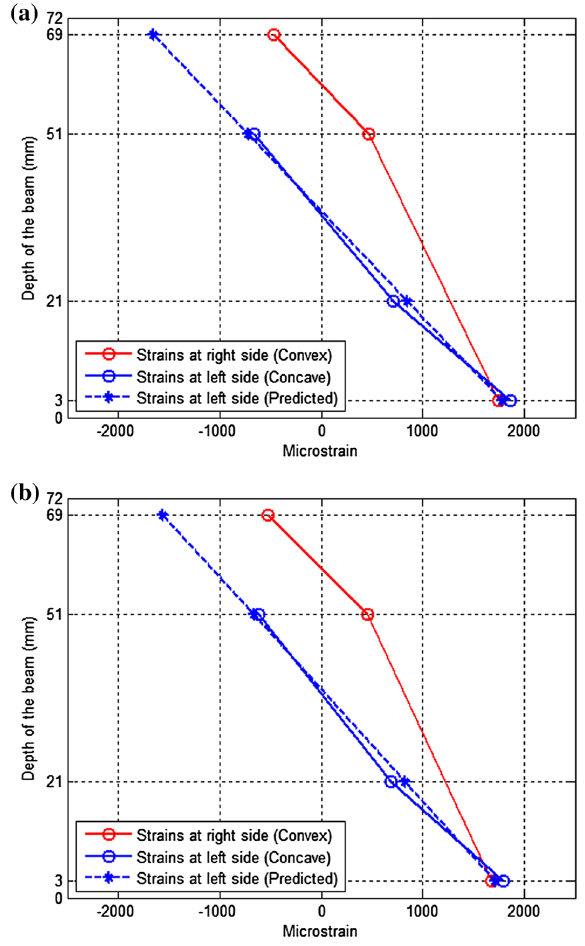
Fig. 16 Strain distribution along the depth of the a ST1 and b ST2 beams at the critical